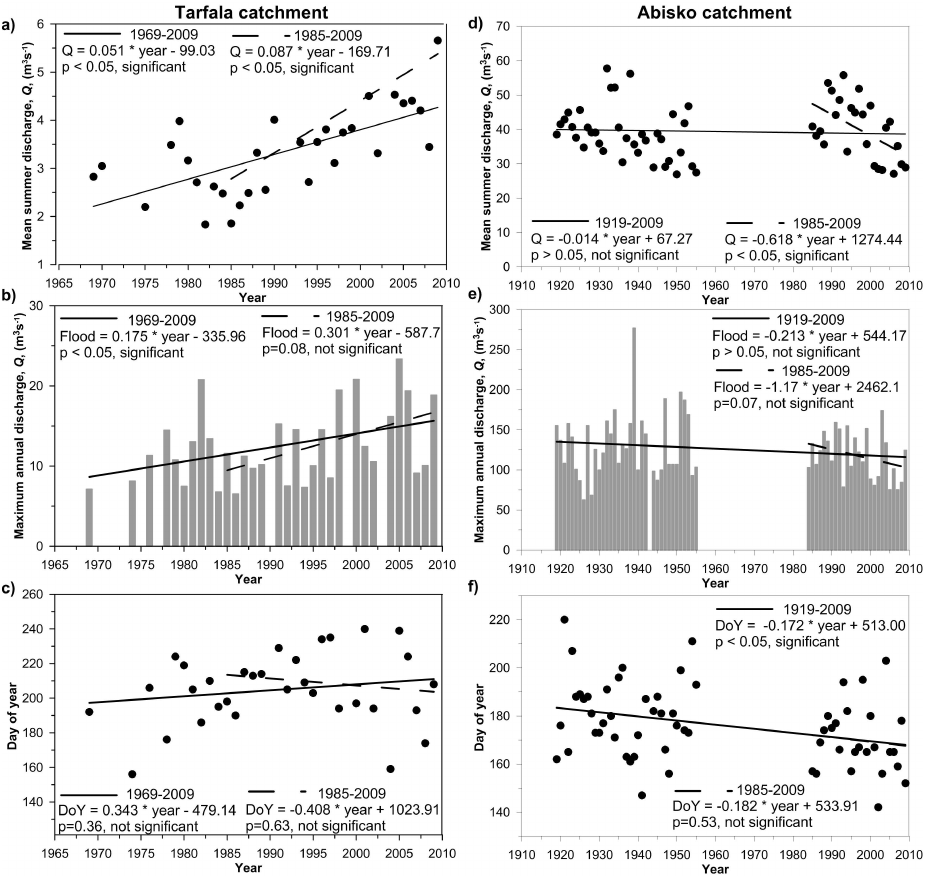
Fig. 4. Statistical characteristics of the Tarfala and Abisko discharge. (a) , (d) Time series of mean summer (JJA) discharge; (b) , (e) time series of the annual maximum discharge (floods); and (c) , (f) time series of the flood occurrence date of annual maximum flood events in the Tarfala and Abisko catchments, respectively. The solid lines represent linear trends over the full record period in each catchment. The dashed lines represent linear trends for the common time period 1985–2009 for which discharge records were available in both